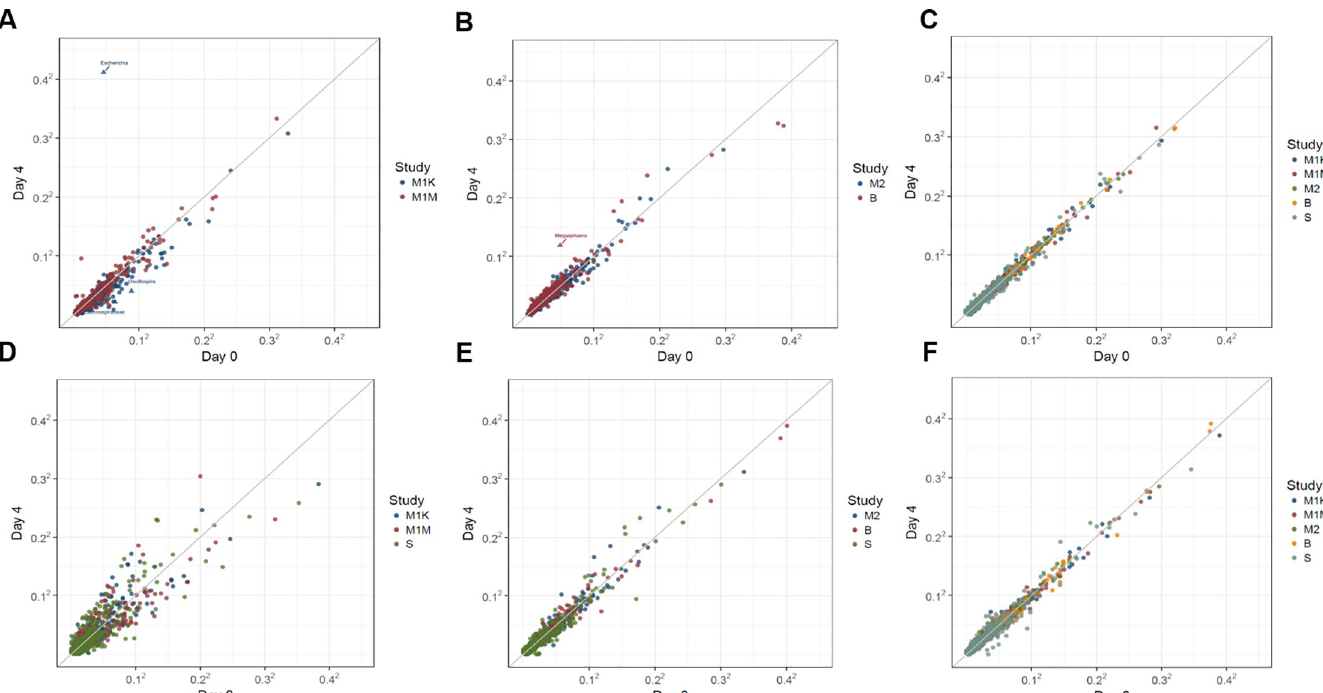
Fig 2. Comparison of square root transformed mean OTU abundance between day-0 and day-4/7 of freezing for fecal samples from 132 participants in five studies (Mayo 1-Knight lab, Mayo 1-Mayo lab, Mayo 2, Bangladesh, and Colorado), collected using six different methods (A) no-solution, (B) FIT tubes, (C) FOBT cards, (D) 70% ethanol, (E) 95% ethanol, and (F) RNA later . Abbreviations : B , Bangladesh; FIT , fecal immunochemical test tubes; FOBT , fecal occult blood test cards; FTA , Flinders Technology Associates cards; M1K , Mayo 1 , Knight Laboratory; M1M , Mayo 1 , Mayo Laboratory; M2 , Mayo 2; OTU , operational taxonomic unit; S , Colorado Study